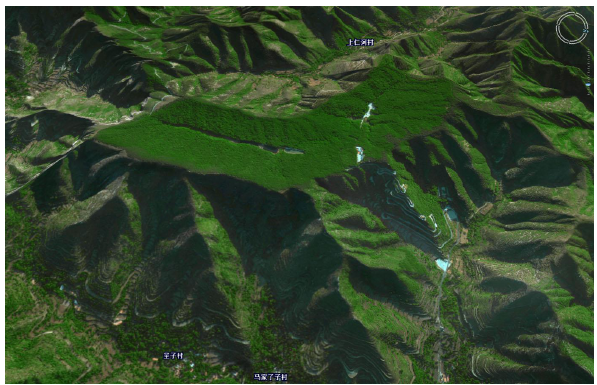
Figure 17. The Yangtian